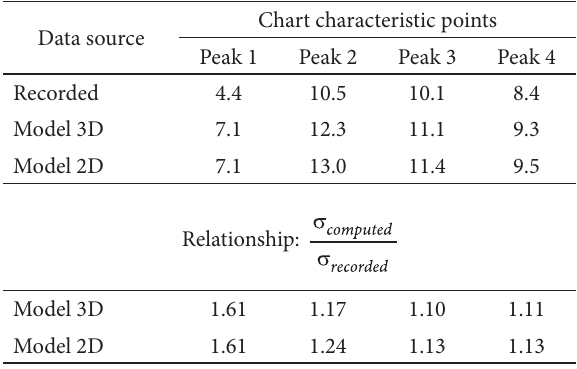
Table 4. Recorded and computed normal stress peaks, MPa, at the top fibre of bottom flange